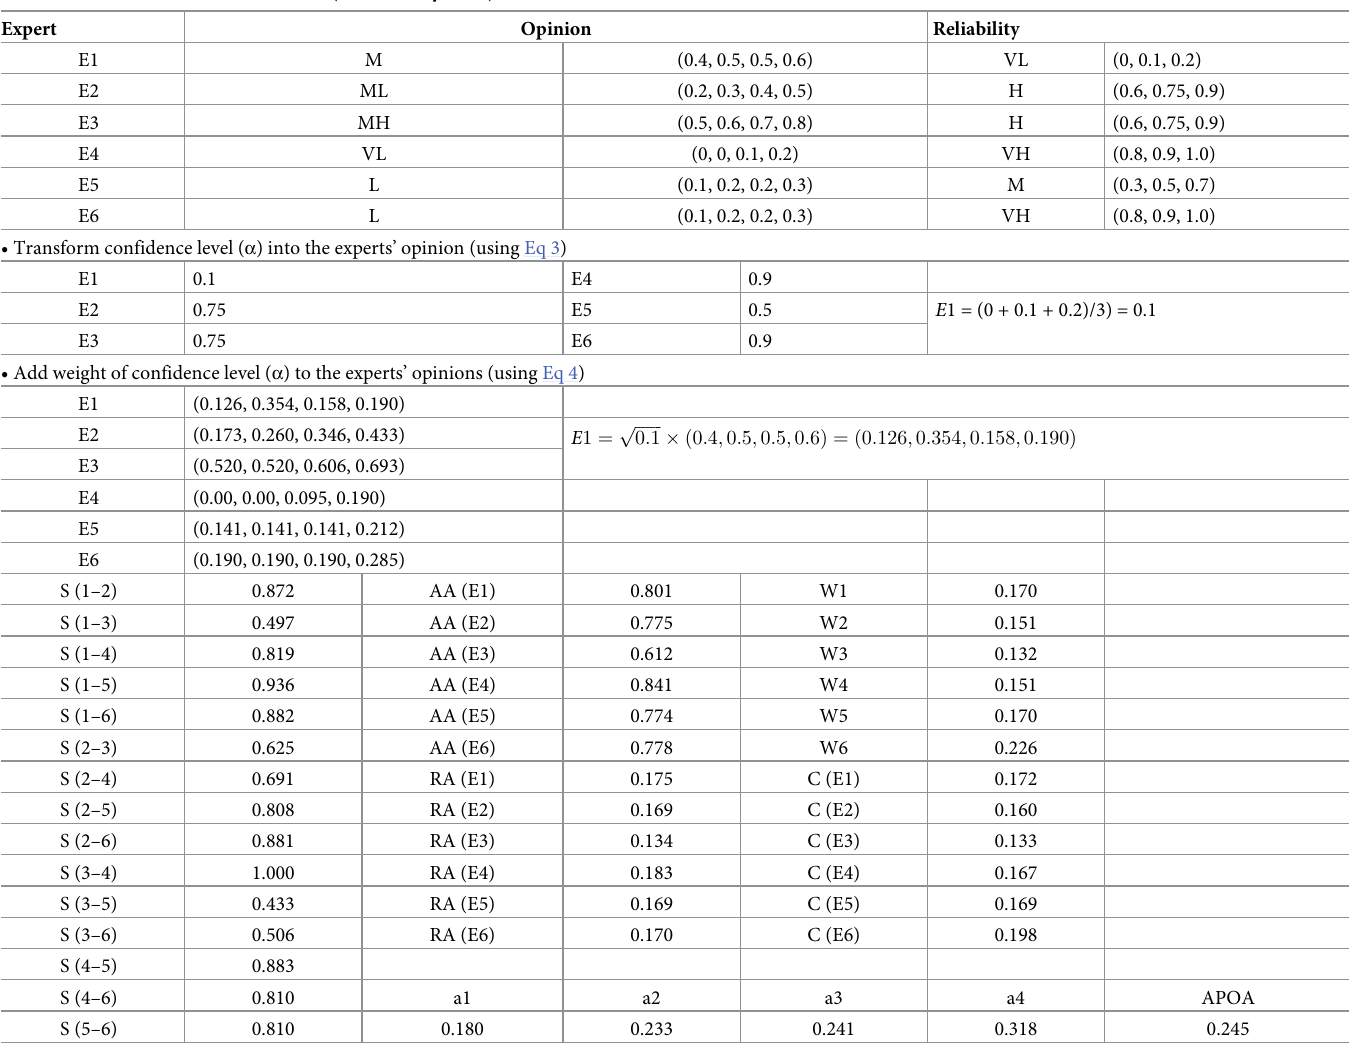
Table 8. Z-APOA for subtask T1-EPC1 (considered β = 0.5). Expert